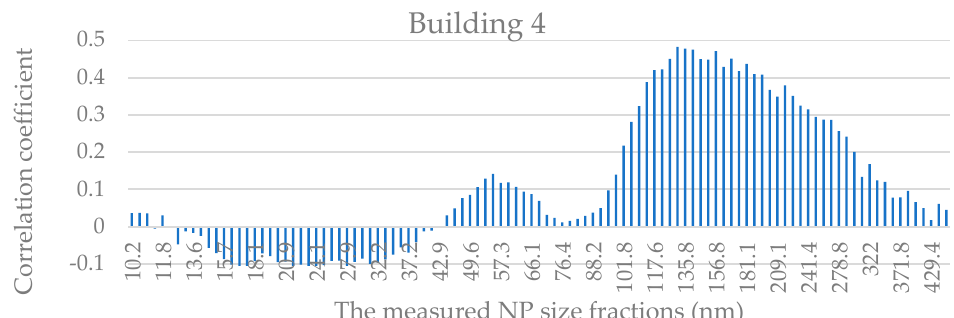
Figure 12. The correlation coefficients (Pearson) between the ventilation flow and the NP number concentration during the one-week measurement period presented for each size fraction in Building 4 during the heating season.